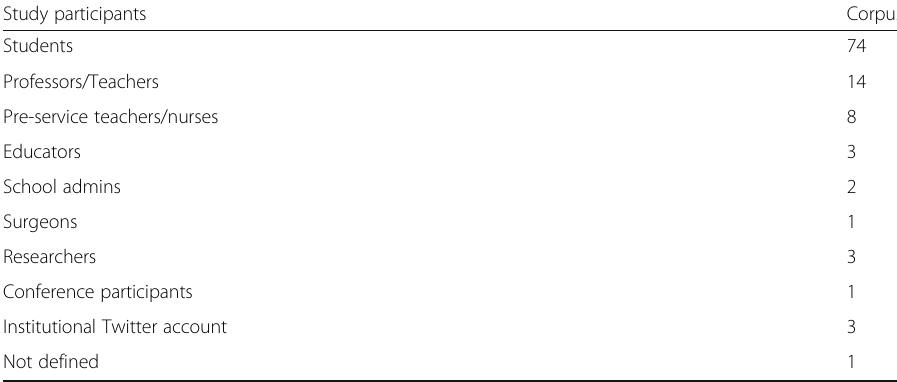
Table 4 Study participants